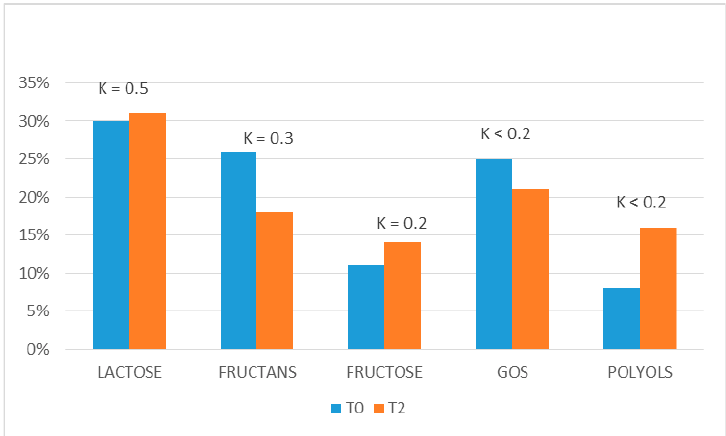
Figure 5. Perception of trigger foods. The concordance (expressed by Cohen’s K) between the perception of which groups of FODMAP were able to trigger IBS symptoms before starting LFD (T0) and after the end of the reintroduction phase (T2). The reported results refer to the 41 patients evaluated at T3.